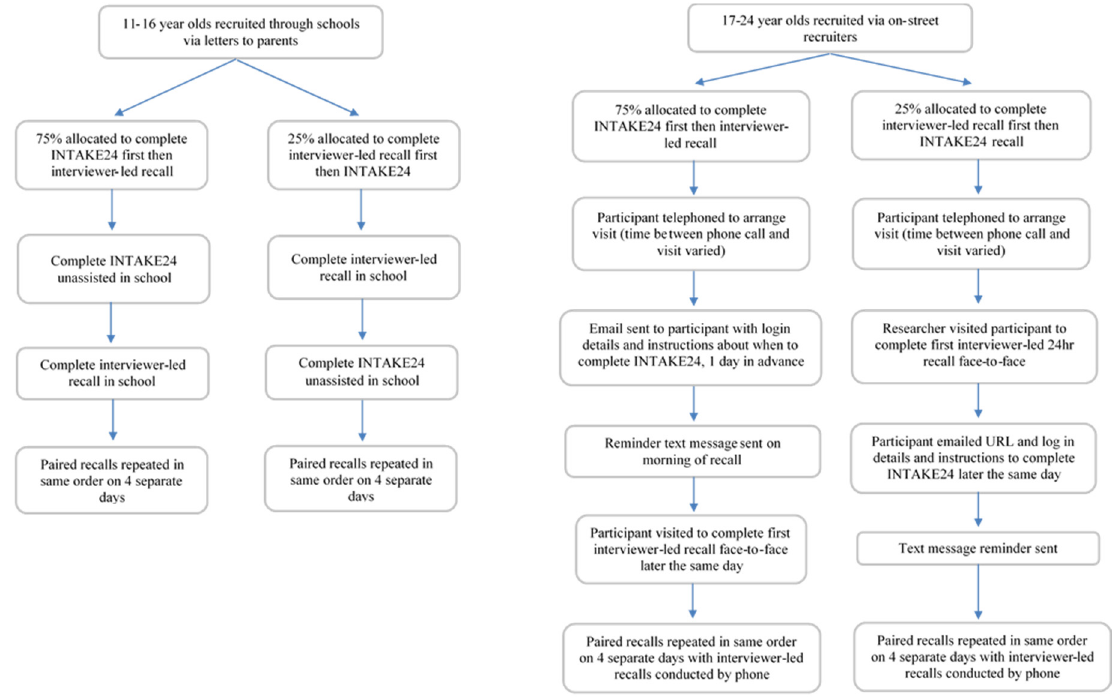
Figure 3. Flow chart detailing participant flow through the study.